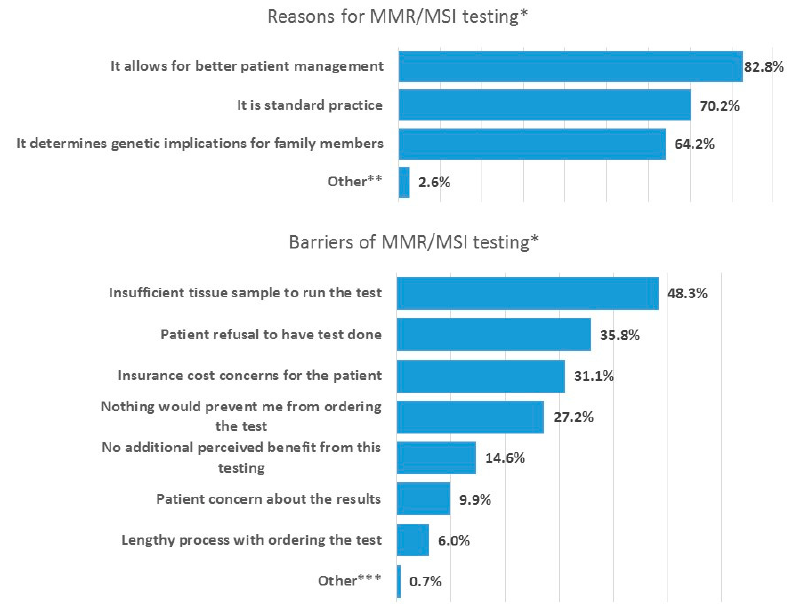
Figure 1. Reasons and barriers for ordering MMR / MSI testing—% of physicians agreeing with each statement. * Multiple selections were allowed. Thus, total percentage will not add up to 100%. ** Answer included: eligibility for certain therapies, and compliance with guidelines. *** Answer included: Patients do not go to third line.